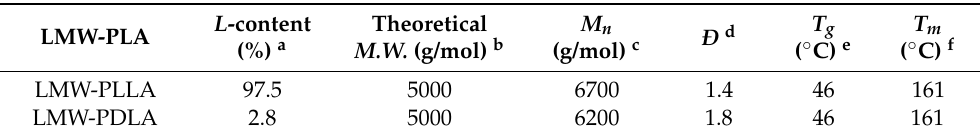
Table 1. L -enantiomer contents, molecular weight characteristics, and thermal properties of LMW- PLLA and